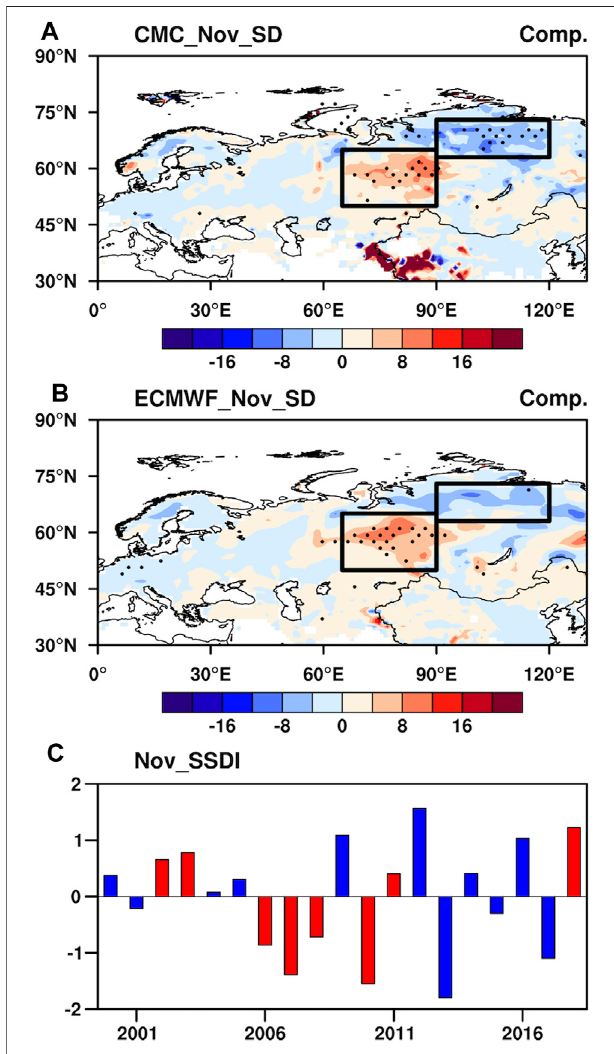
FIGURE2| Compositespatialpatternsofsnowdepth(SD,units:mm)in the previous November between SH + − and SH − + for two datasets during 2000/01 – 2018/9: (A) Canadian Meteorological Centre (CMC) data; (B) ECMWF (European Center for Medium-Range Weather Forecasts) interim reanalysis data. (C) Normalized time-series of Siberian snow depth index(SSDI)basedonCMC.Dottedregionsin (A,B) arestatisticallysigni fi cant at the 90% con fi dence level, based on the t -test. The black rectangle represents the key area of Siberian snow depth (SSD) [(50 ° – 65 ° N, 65 ° – 90 ° E), (63 ° – 73 ° N, 90 ° – 120 ° E)] in (A,B) . Years of heaviest (lightest) SSD corresponding to SH + − (SH − + ) are shaded by red bars in (C)